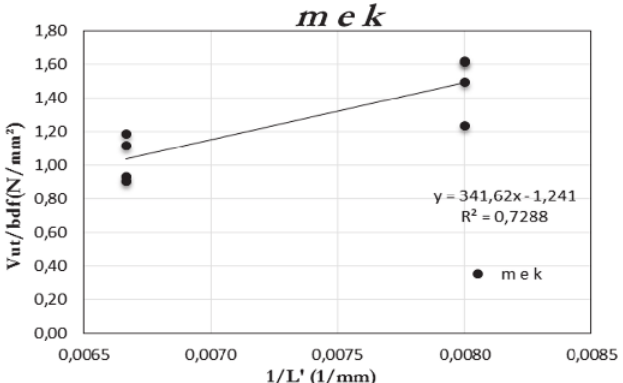
Figura 9 Regressão linear dos dados de ensaio dos modelos